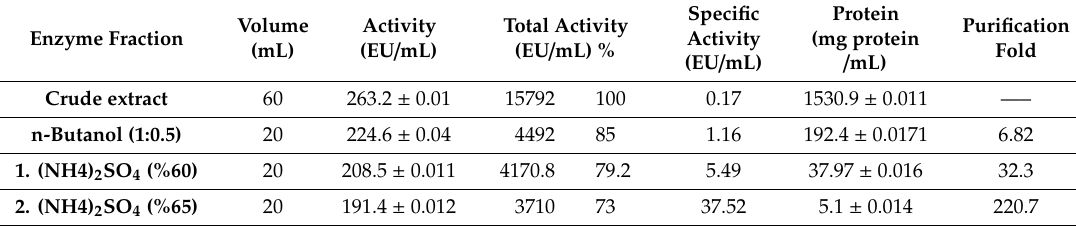
Table 1. The purification process of purified pectin lyase enzyme from Pseudomonas putida.